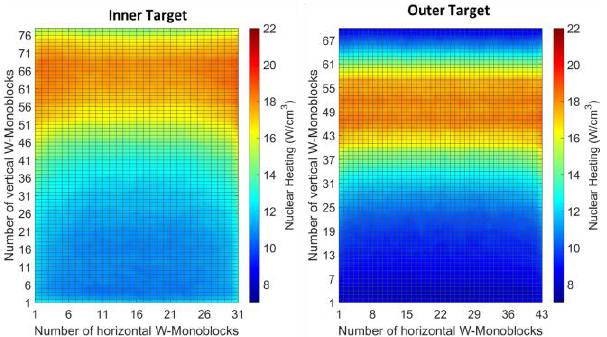
Figure 12. Nuclear heating (W/cm 3 ) distribution on W-monoblocks of the inner ( left ) and outer ( right ) target, with HCPB blanket.